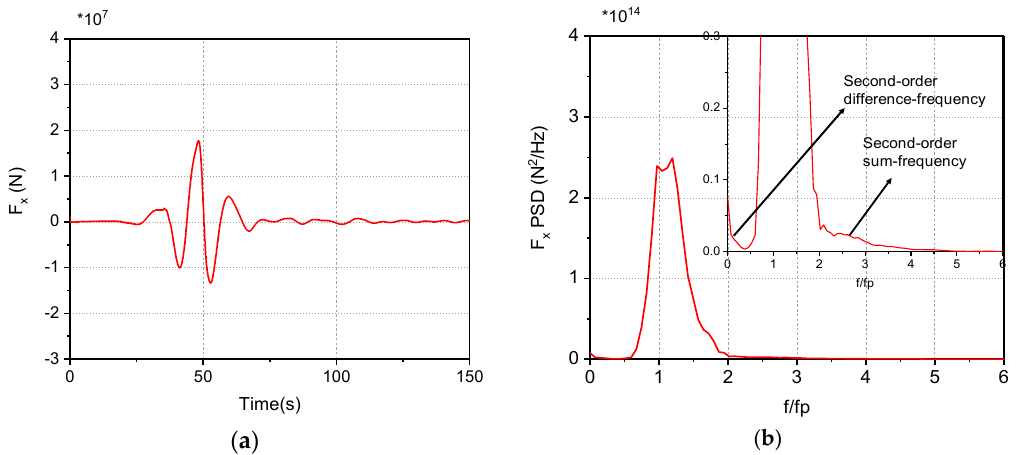
Figure 25. Inline force F x and PSDs analysis for a parked wind turbine subject to focused wave: ( a ) inline force F x ; ( b ) PSDs of inline force.